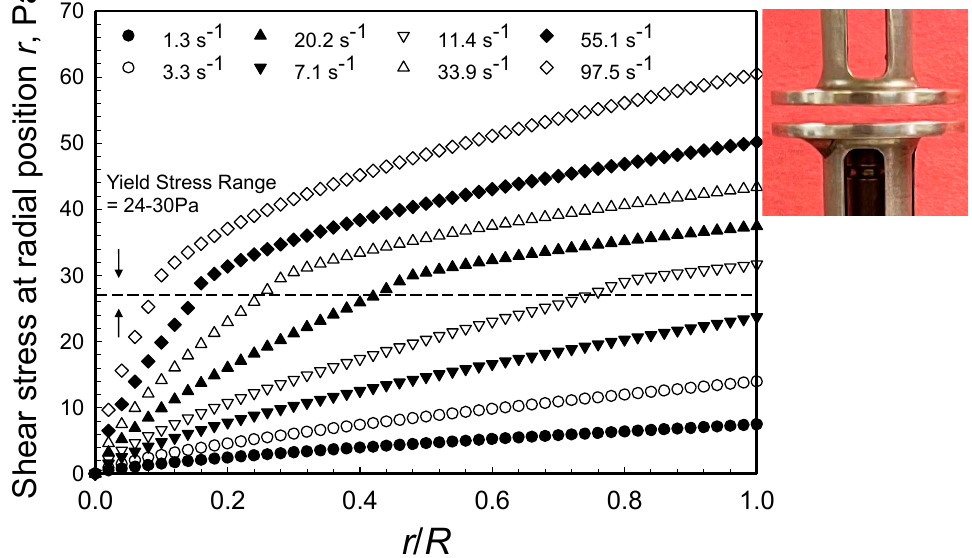
( ) τ r θ in steady torsional flow between . z γ aR = Ω R / H , between 1.3 to 97.5 s − 1 ( H = 1 γ = Ω  , between 1.3 to 97.5 s − 1 ( H